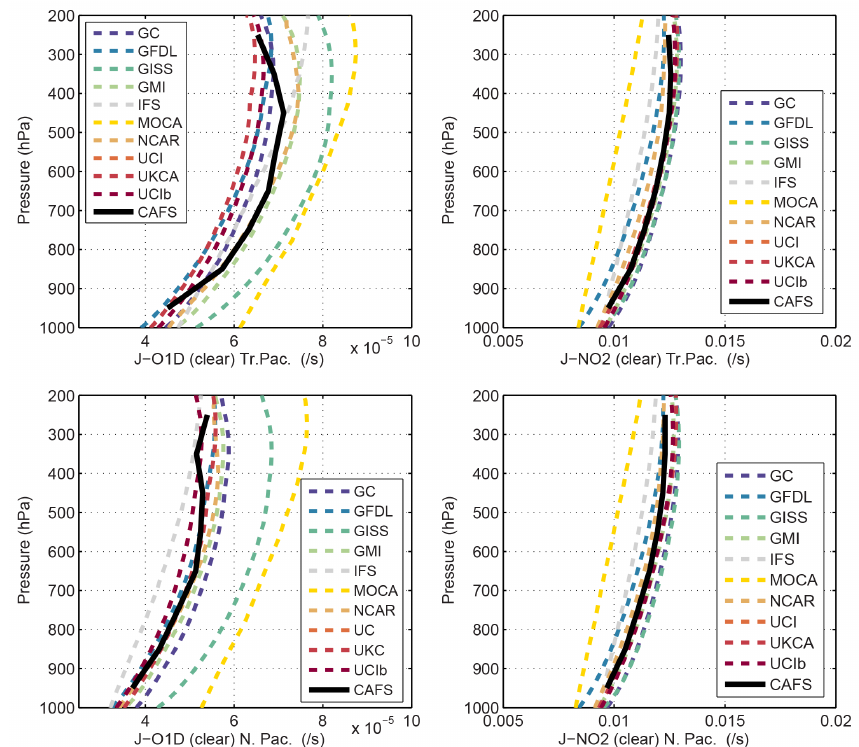
Figure 2. Profiles of clear-sky J -O1D and J -NO2 for the tropical and North Pacific blocks. See Fig. 1. CAFS here refers to TUV J s modeled at each point along the flight path. The UCI and UCIb models are not separable since both have the same clear-sky J s. The spread in J -NO2 is likely due to different choices for interpolating cross sections and quantum yields. The J -O1D spread may be caused by the different ozone columns in the Tropics; see Fig.